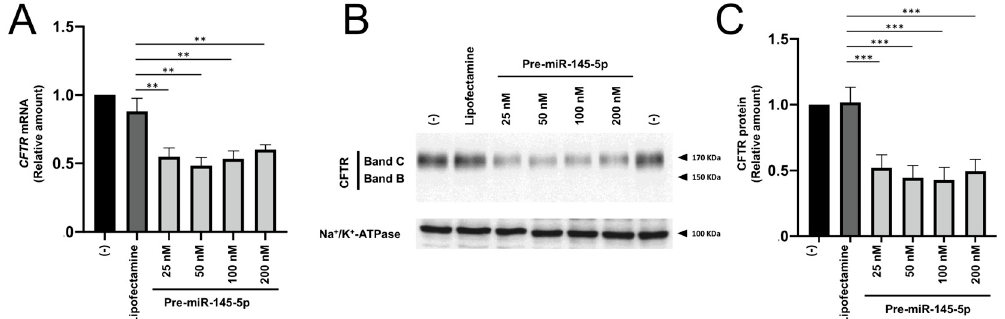
Figure 3. Effects of treatment of Calu-3 cells with increasing concentrations of pre-miR-145-5p. The length of treatment was 72 h. ( A ): RT-qPCR analysis; ( B ): representative Western blotting. ( C ): relative values of CFTR content with respect to Na+/K+-ATPase. The uncut version of the gel is shown in Supplementary Figure S2. (-) = untreated cells. ** p < 0.01, *** p < 0.001.